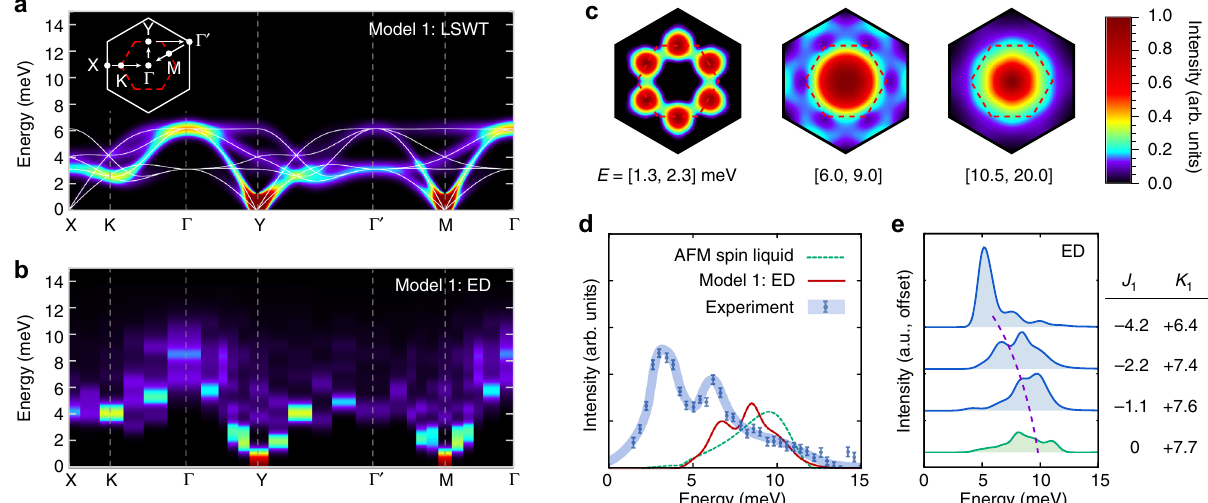
Fig. 2 Neutron scattering intensity Ið k ; ω Þ within the nnHK model. a – c Detailed results for Model 1 ( J 1 = − 2.2, K 1 = +7.4 meV): a Ið k ; ω Þ computed via LSWT; results are averaged over the three zigzag ordering wavectors, parallel to the X-bonds, Y-bonds, and Z-bonds. Inset: De fi nition of Brillouin zone and high-symmetry k -points. b ED results, combining data from several 20-site and 24-site periodic clusters (see “ Methods ” ). c ED k -dependence of Ið k ; ω Þ integrated over the indicated energies, as obtained from a single 24-site cluster respecting all symmetries of Eq. (1) (see “ Methods ” ). d Comparison of Γ - point intensities for the K 1 = +7.7 meV AFM spin liquid (exact results 53,54 ), Model 1 (ED), and the experimental data for α -RuCl 3 12 . e Evolution of the ED Γ - point intensity with decreasing J 1 = K 1 j j , showing absence of low-energy intensity close to the K 1 > 0 spin liquid. The top three interaction sets correspond to zigzag order, while the bottom is the K 1 > 0 spin liquid. For all spectra, a Gaussian broadening of 0.5 meV has been